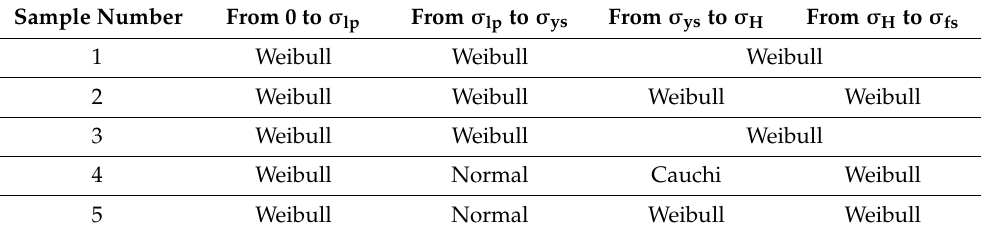
Table 3. Stress distribution types in static tensile stress sections of 3D-printed 60Al 2 O 3 /40PLA specimens. Sample